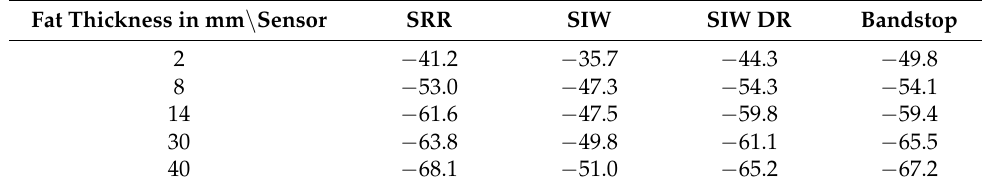
Table 2. Strength of electric field, in dB ( µ V/m), 1 mm into muscle layer.